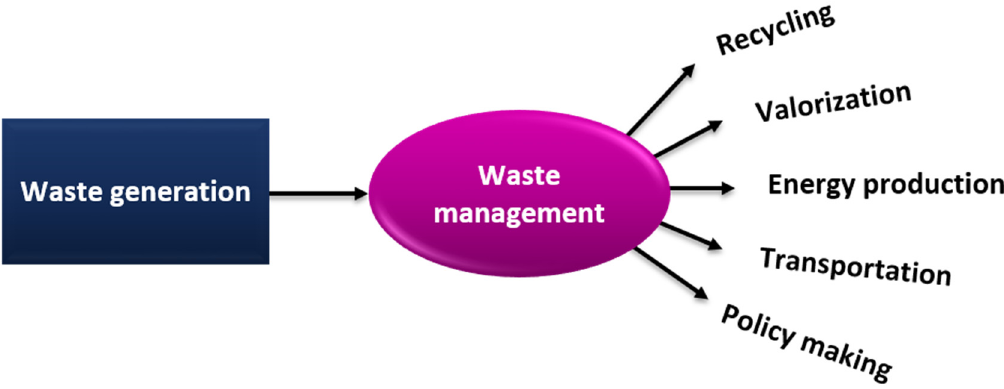
Figure 2. Strategies for recycling of waste materials .